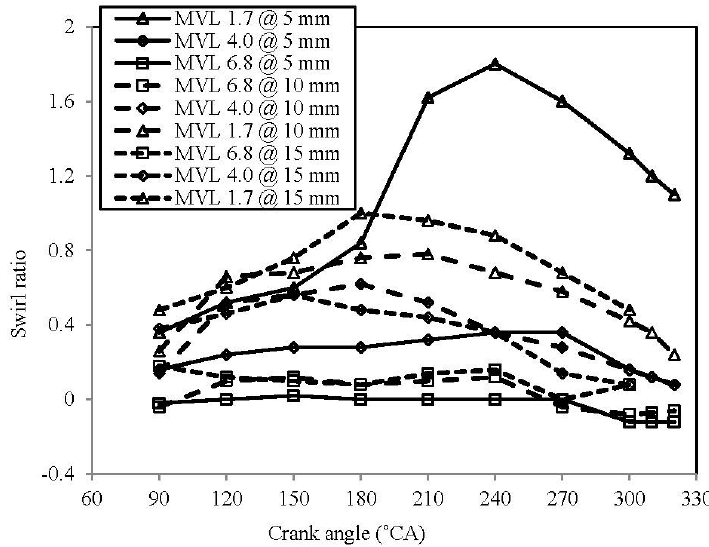
Figure 8. Comparison of swirl ratio variations with CA at the different measured planes between different MVLs (5 mm—the measured plane of 5 mm under TDC; 10 mm—the measured plane of 10 mm under TDC; 15 mm—the measured plane of 15 mm under TDC).